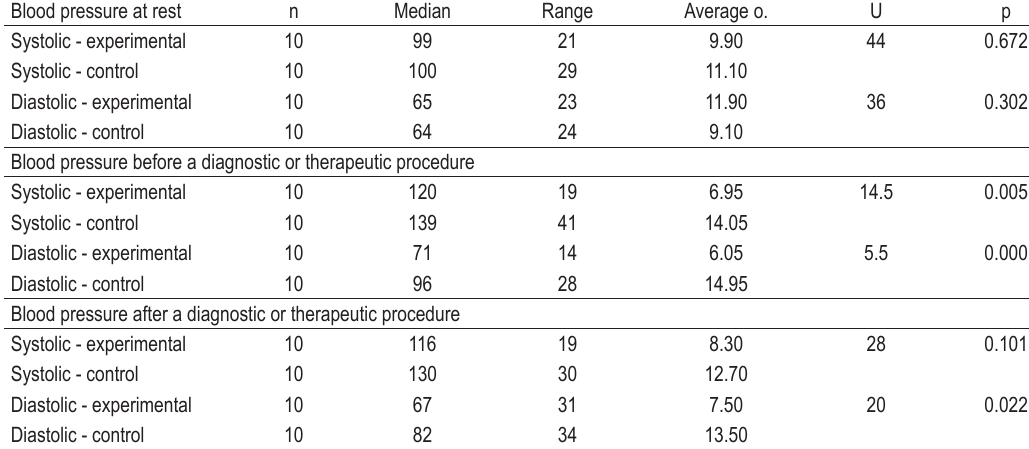
TABLE 2. Blood pressure (Mann‑Whitney